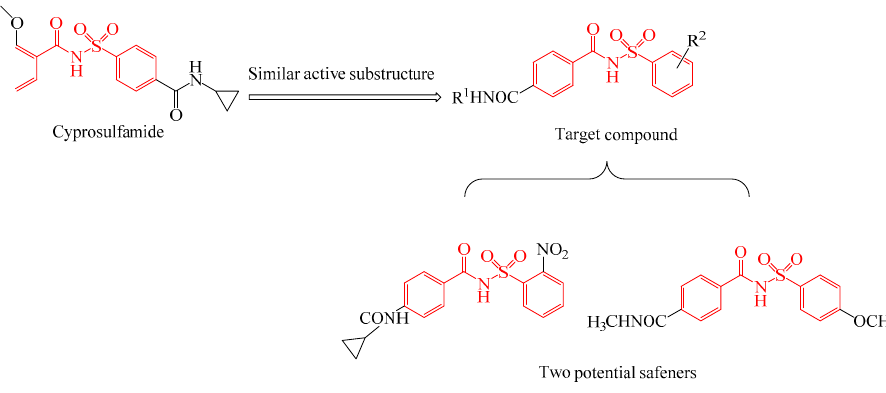
Scheme 1. Design of new molecules as potential safeners.